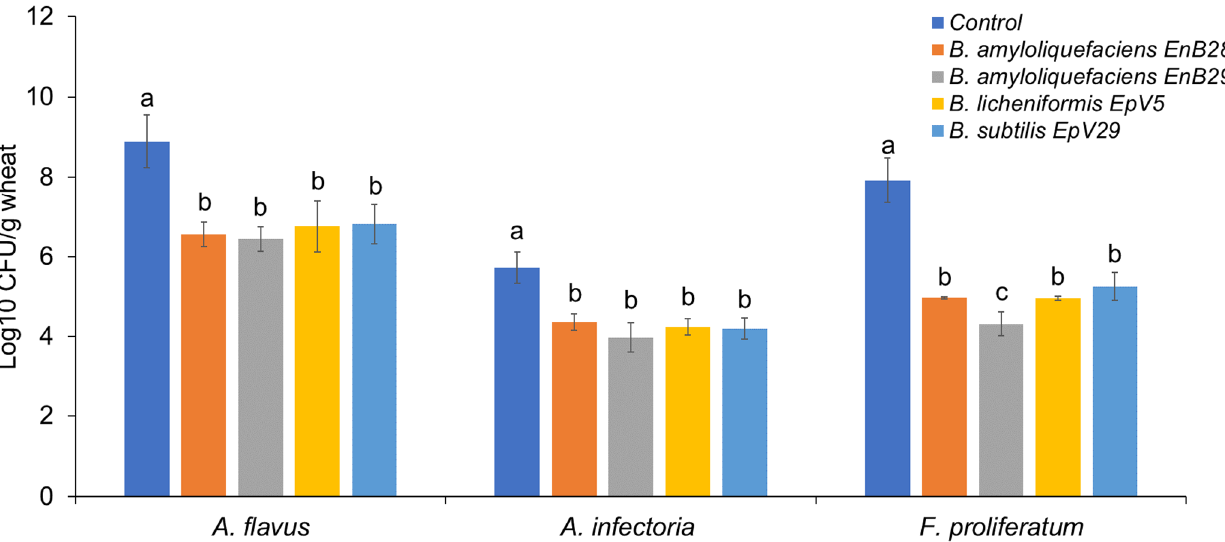
Figure 6. Antagonistic activity of four selected bacterial isolates against three mycotoxigenic fungal pathogens in stored wheat grains. Data are means of at least three independent repetitions ± standard error. One-way ANOVA differences were considered significant when p < 0.05. Different letters above the error bars indicate statistically significant differences among treatments in each group as determined based on Duncan’s multiple range test.